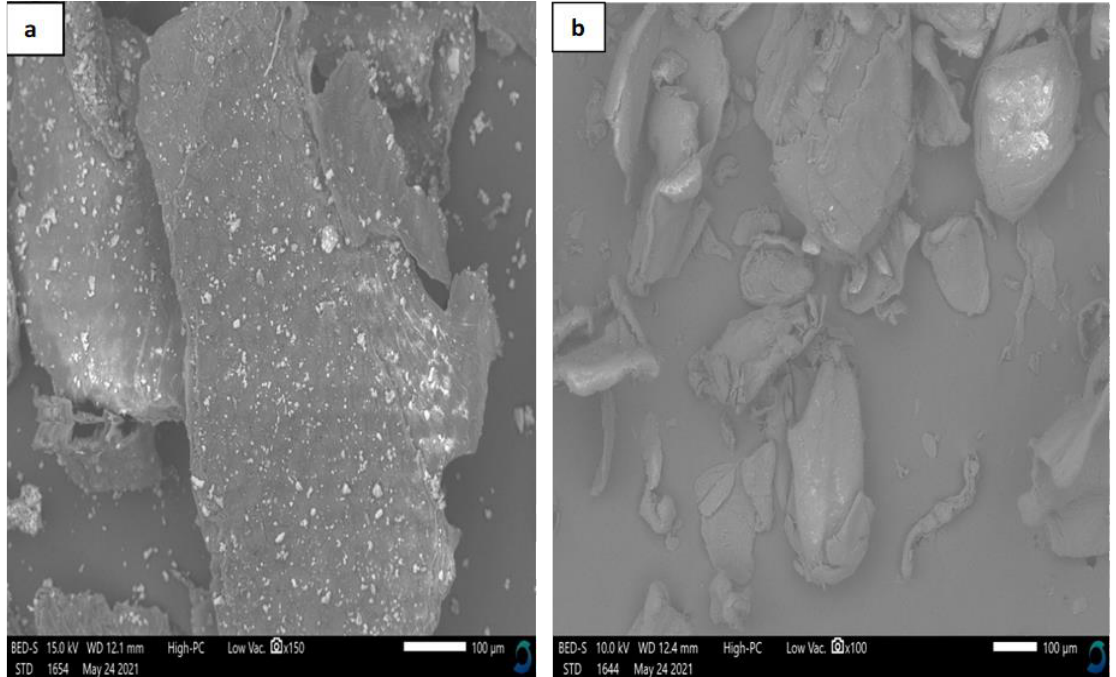
Figure 4. Scanning electron micrographs of ( a ) chitosan from BSF pupal shell chitin obtained via the use of chemicals, and ( b ) commercial shrimp chitosan (Sigma-Aldrich, St. Louis, MI, USA).